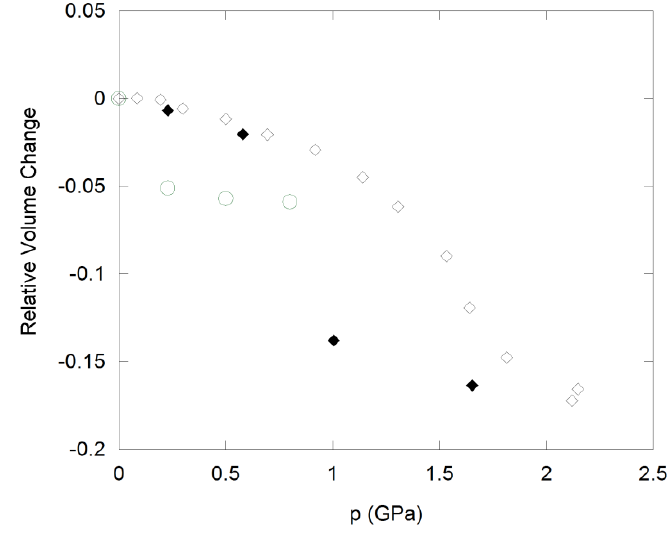
Figure 4. Compressibility of cubic ZrW hydrostatic conditions. Open symbols: Data collected upon compression; solid symbols: Data collected upon